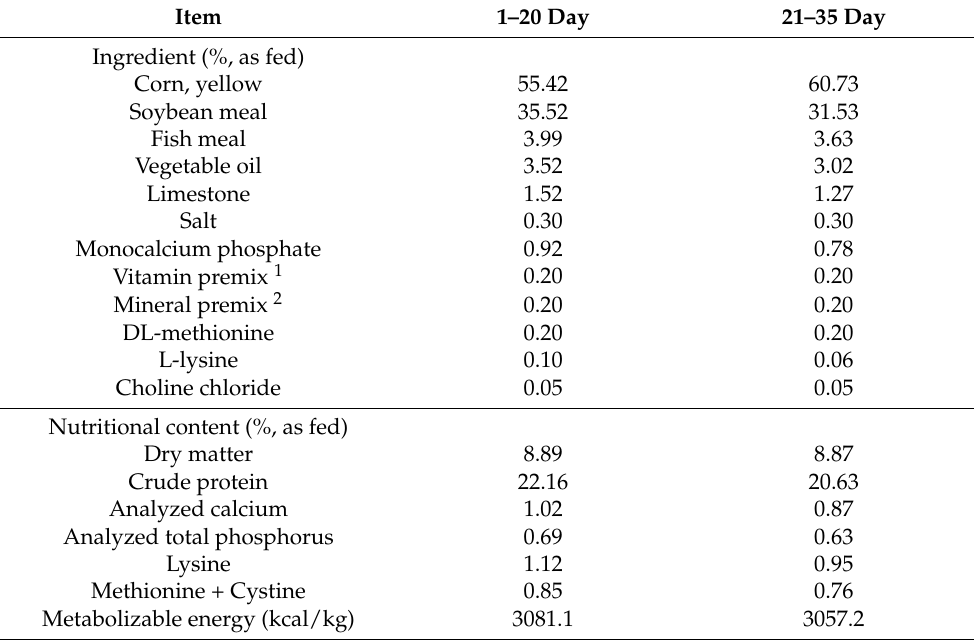
Table 1. Ingredients and nutrition composition of basal